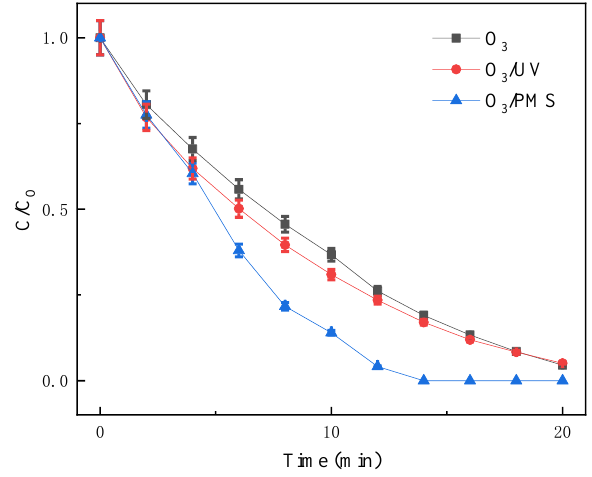
Figure 3. Degradation effect of different treatment methods on SDZ (reaction conditions: SDZ = 10 mg/L, O 3 = 3 mg/L, T = 25 ± 0.5 °C, pH = 6.8 ± 0.1, O 3 /PMS (persulfate) (PMS = 22.8 mg/L), UV = 0.9 mw/cm 2 ). Table 2. Pseudo-first-order rate constant of SDZ degradation by O 3 , O 3 /UV, and O 3 /PMS (reaction conditions: SDZ = 10 mg/L, O 3 = 3 mg/L, T = 25 ± 0.5 °C, pH = 6.8 ± 0.1, O 3 /PMS (PMS = 22.8 mg/L), UV = 0.9 mw/cm 2 ).